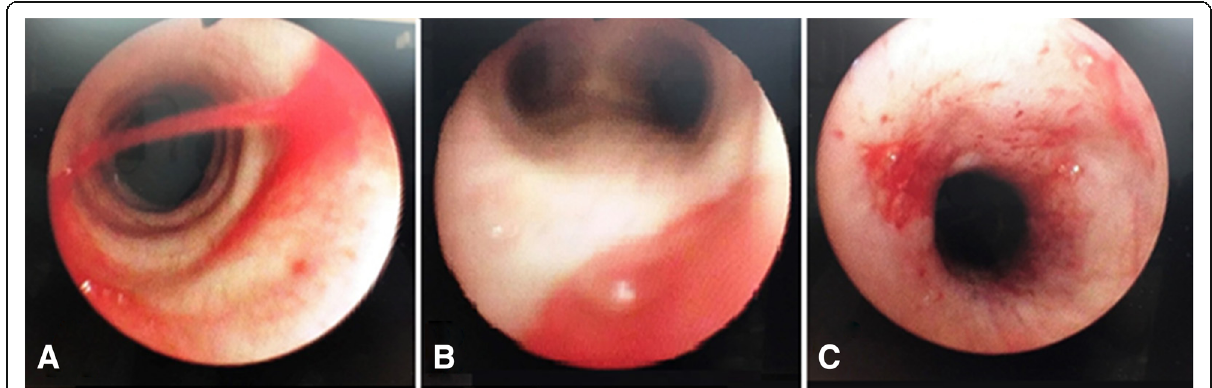
Fig. 1. Bronchoscopy photos. a Complete tracheal rings with the absence of the membranous portion of the trachea immediately below the cricoid cartilage to the tracheal bifurcation were observed. b Membranous tissue was noted at the bifurcation. c Petechiae of the mucosa immediately below the cricoid cartilage was observed